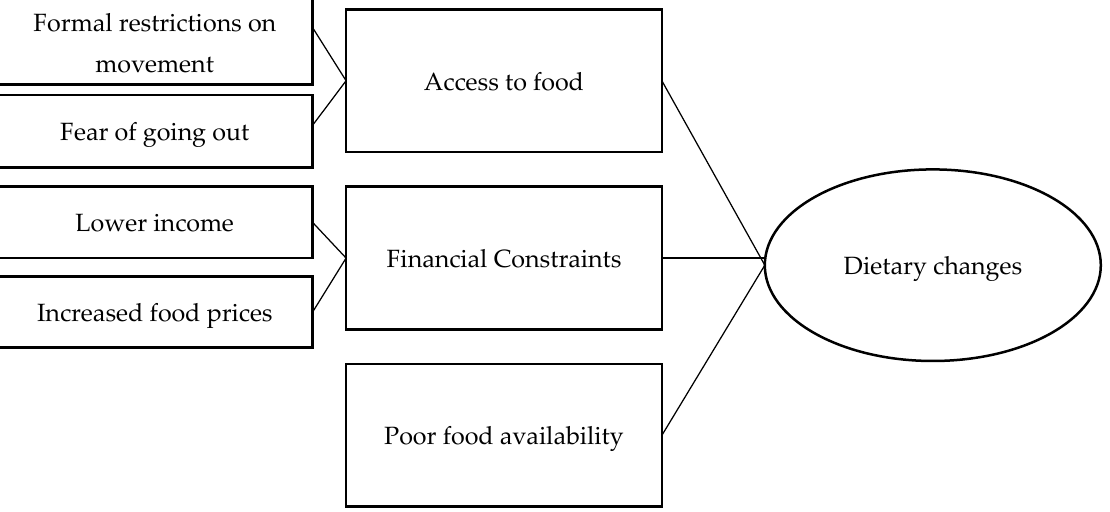
Figure 1. Thematic map showing the main themes and subthemes of reasons for making dietary changes.